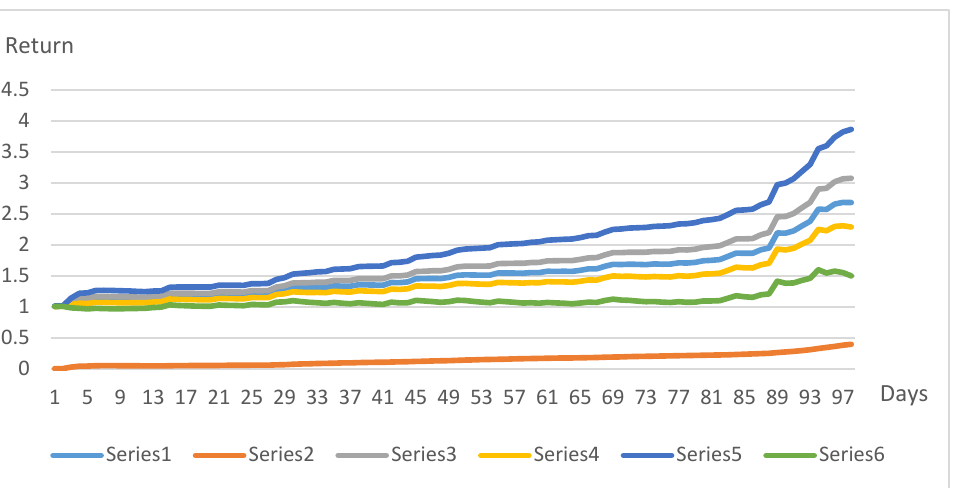
Figure 7. Confidence intervals of return on 3 stocks’ portfolio (US market) (source: compiled by the authors based on Yahoo Finance data and own calculations).